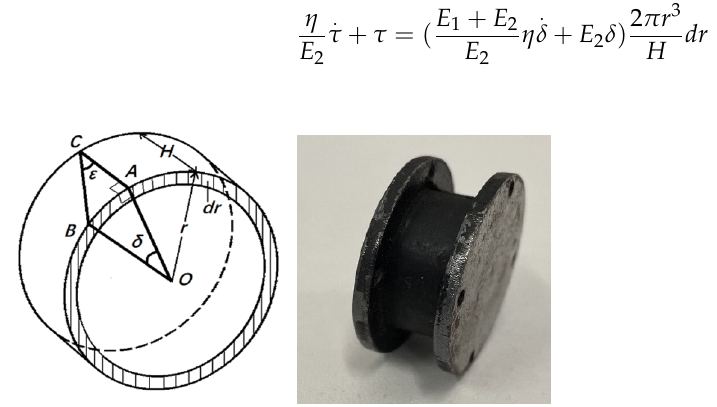
Figure 3. Rubber and the model figure of rubber torsion deformation. Output torque T of rubber is obtained by integrating micro torque τ on the radius r